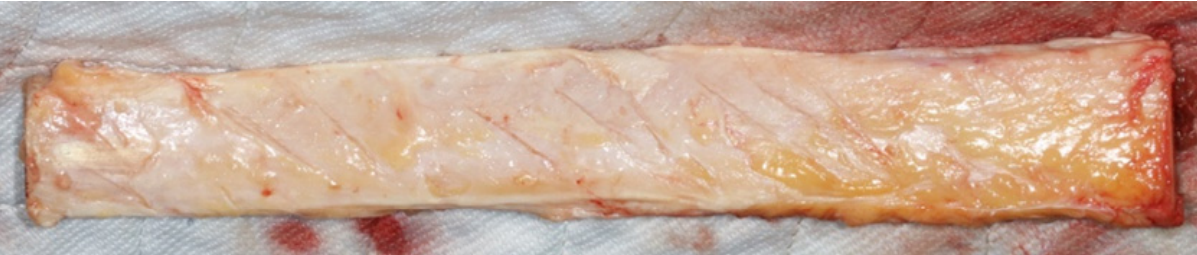
Figure 1. A six-inch-long tibial section, before the placement into a 37 °C water bath, to simulate normal body temperature.